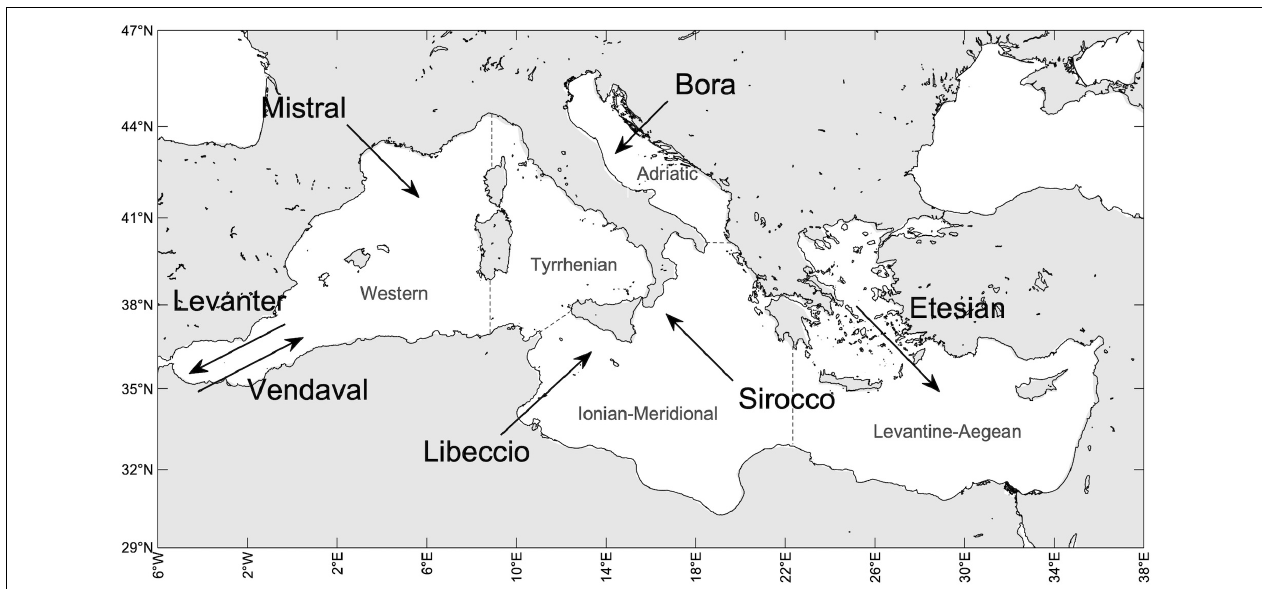
FIGURE 1 | Map of the Mediterranean Sea basin and sub-basins (separated for the climate analysis purposes of this paper by dashed gray lines). The most relevant regional winds are indicated by black arrows denoting blow-to